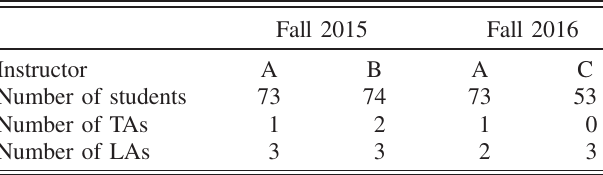
TABLE I. Student enrollment and teaching staff for the MI-M courses. There were two sections of MI-M in Fall 2015 and two in Fall 2016. There were three instructors teaching the course (denoted by A, B, and C). The LAs and TAs varied between semesters.